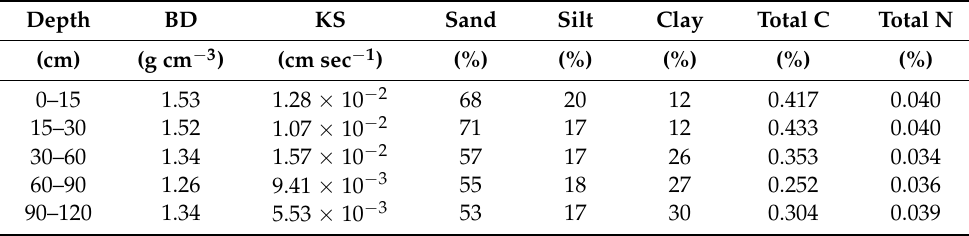
Table 1. Bulk density (BD), hydraulic conductivity (KS), particle size distribution (sand, silt, clay), total carbon (C), and total N of soil samples.